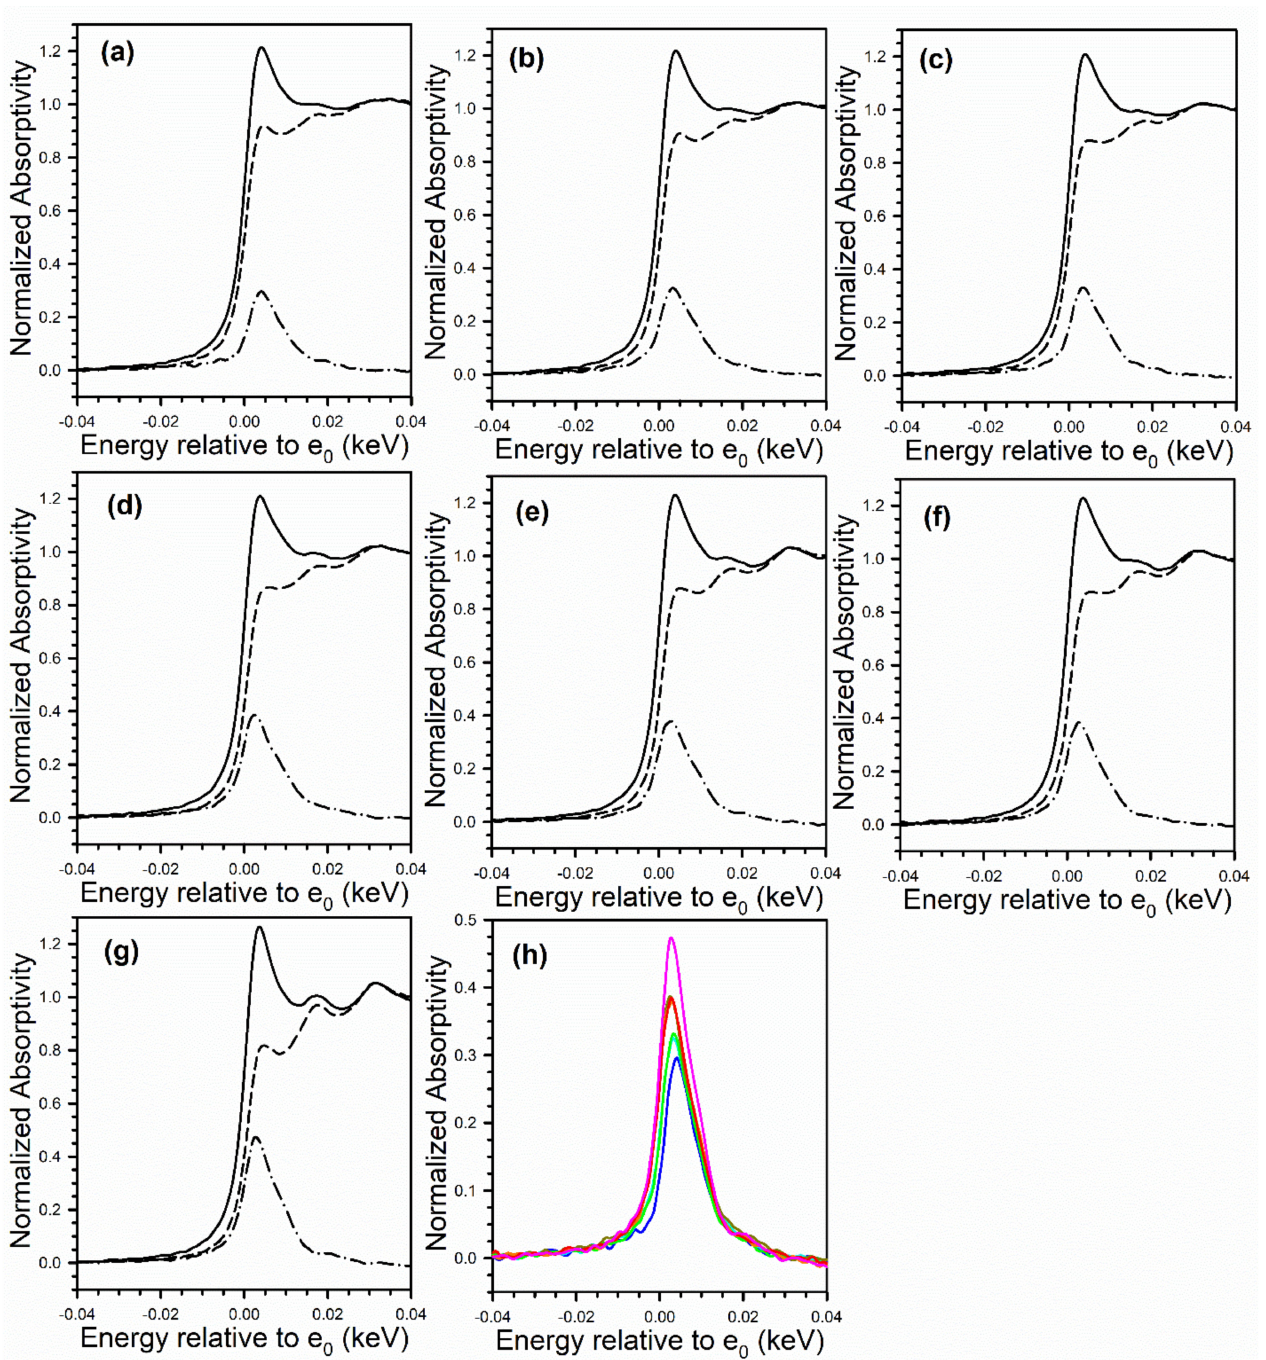
Figure 8. XANES spectra at the Pt (solid line) L-3 edge and (dashed) line L-2 edge, as well as (dash-dotted line) the L 3 –L 2 difference spectra of ( a ) 2%Pt/ZrO 2 , ( b ) 0.93%Rb-2%Pt/ZrO 2 , ( c ) 1.86%Rb-2%Pt/ZrO 2 , ( d ) 2.79%Rb-2%Pt/ZrO 2 , ( e ) 4.65%Rb-2%Pt/ZrO 2 , ( f ) 5.58%Rb-2%Pt/ZrO 2 , and ( g ) 9.29%Rb-2%Pt/ZrO 2 . ( h ) Overlays of L 3 –L 2 difference spectra, showing an increase in intensity with Rb